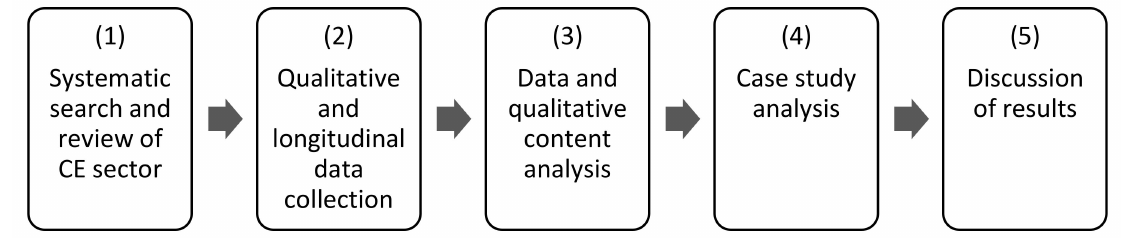
Figure 1. A stepwise approach to investigate Italian community energy (CE)